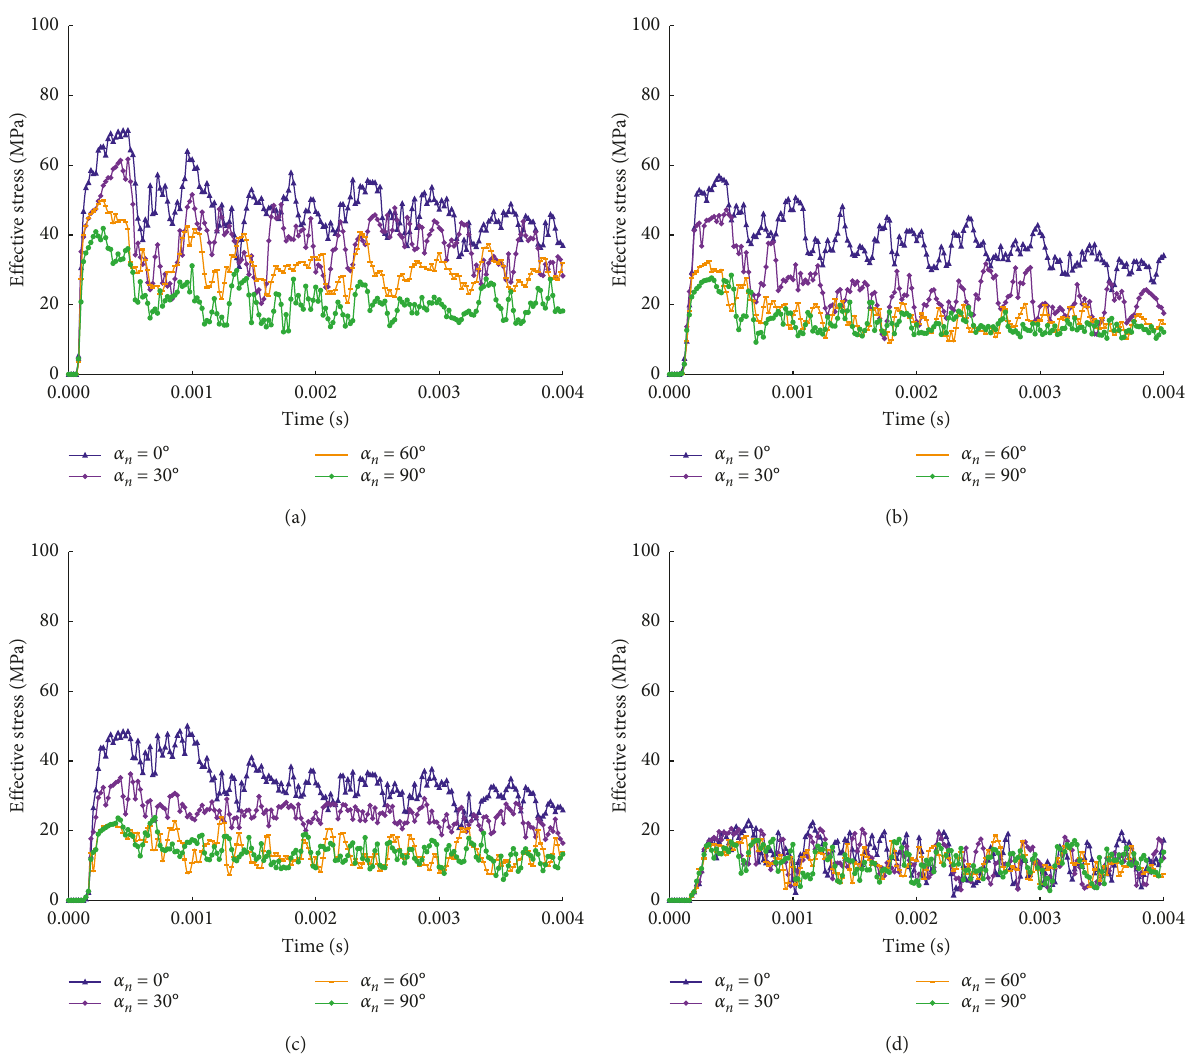
� 8. (b) D � 12. (c) D � 16. (d) D m / r b m / r b m / r b m /